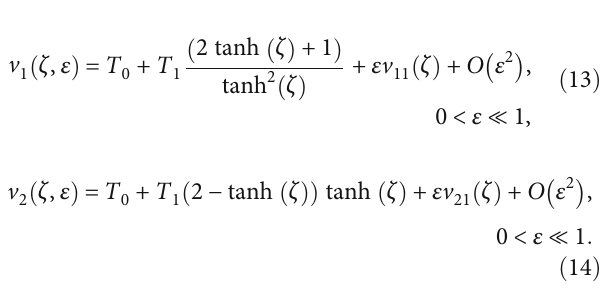
Figure 3: Illustration for the fi rst solitary wave v quantum plasma electrostatic potential ð T 0 = 0, T 1 = 10 Þ ( ζ for the abscissas, v 11 ð ζ Þ for the tial (Eq. (4)).